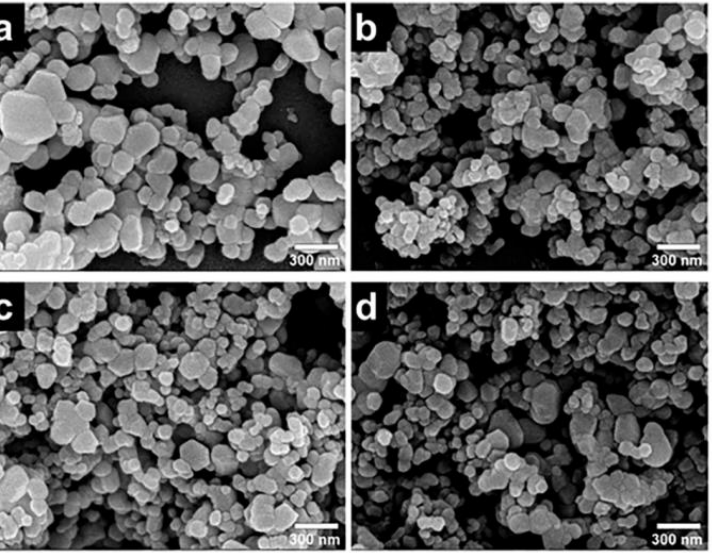
Figure 12. SEM images of Ag-ZnO photocatalysts: (a) [Ag 2+ ]:[Zn2 + ]=0, (b) [Ag 2+ ]:[Zn2 + ]=1, (c) [Ag 2+ ]:[Zn2 + ]=3, and (d) [Ag 2+ ]:[Zn2 + ]=5.